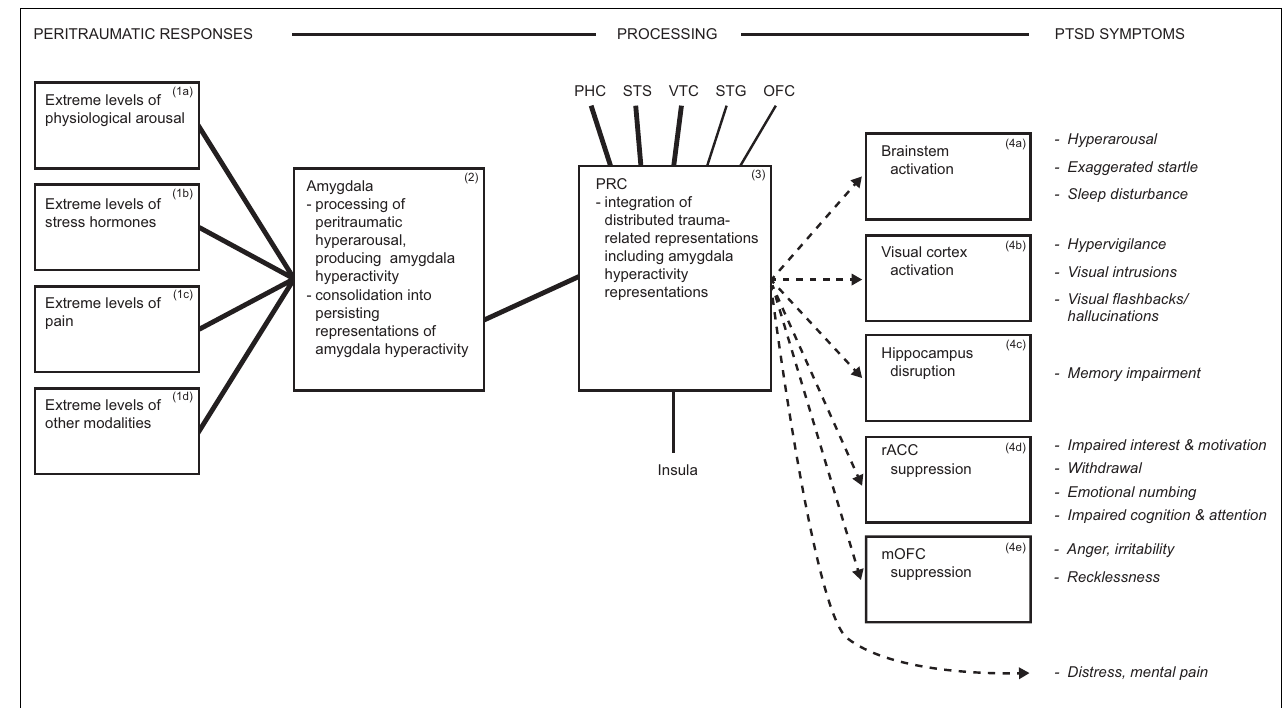
symptoms. E.g., amygdala projections to brainstem reactivate hyperarousal symptoms automatically and involuntarily. , Heavy interconnections; , moderate interconnections; −→ , amygdala hyperactivity representations drive PTSD symptoms. Italics indicate symptoms. Abbreviations: dACC, dorsal anterior cingulate cortex; rACC, rostral anterior cingulate cortex; mOFC, medial orbitofrontal cortex; PHC, parahippocampal cortex; PRC, perirhinal cortex; STG, superior temporal gyrus; STS, superior temporal sulcus;VTC, ventral temporal